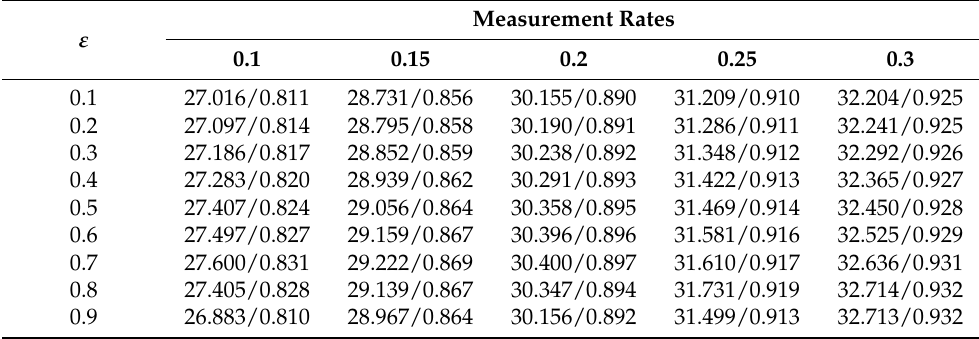
Table 4. PSNR (dB)/SSIM results for the different ε for the Lena image.